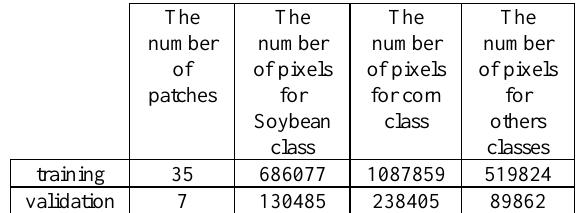
Table 2. The number of used patches/pixels for training and validation of each class.